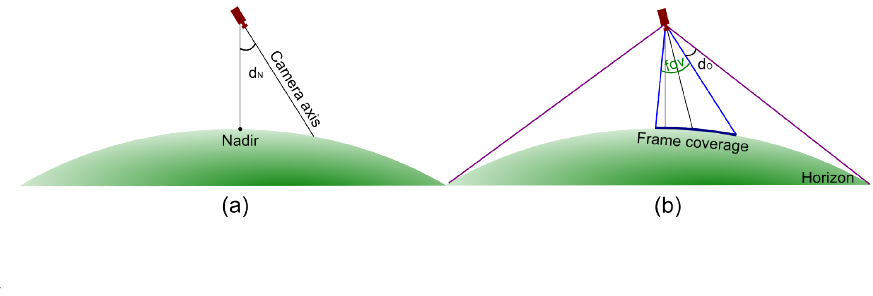
Figure 5. Filtering criteria: ( a ) angle between the camera optical axis and the line from camera optical center to nadir point; ( b ) angular difference between camera field of view and the cone covering the horizon circle